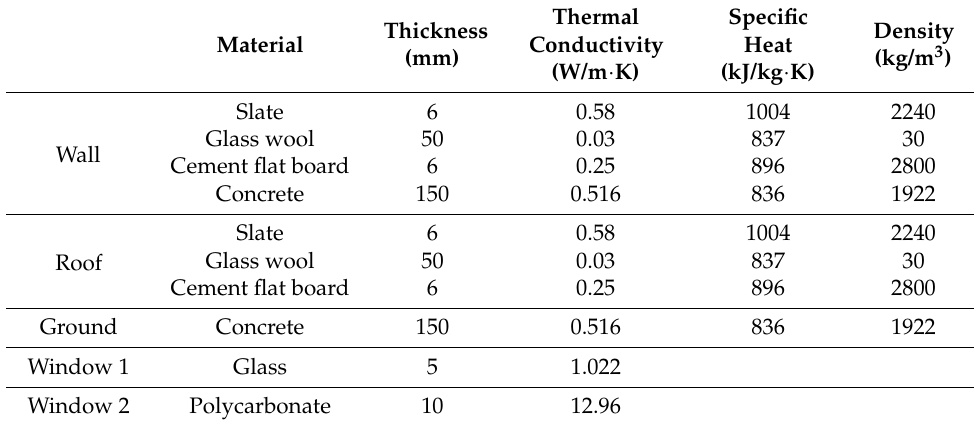
Table 3. Material properties of the insulation of the large-scale assembly